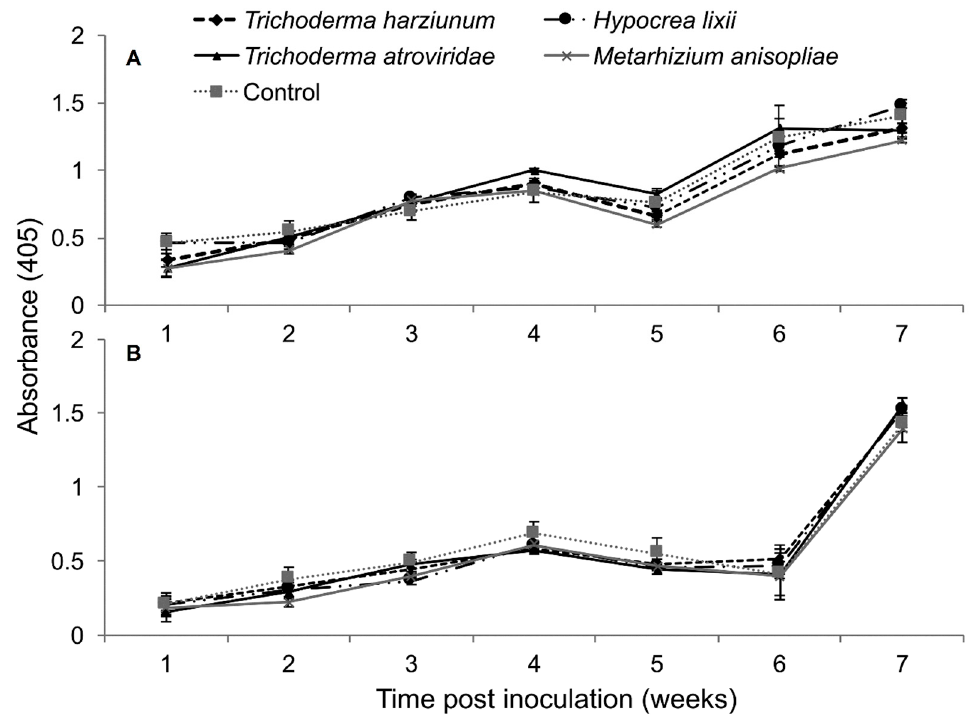
Figure 9. Titer levels of Maize chlorotic mottle virus estimated over time through ELISA as influenced by different treatments of fungal isolates in trials one ( A ) and two ( B ).